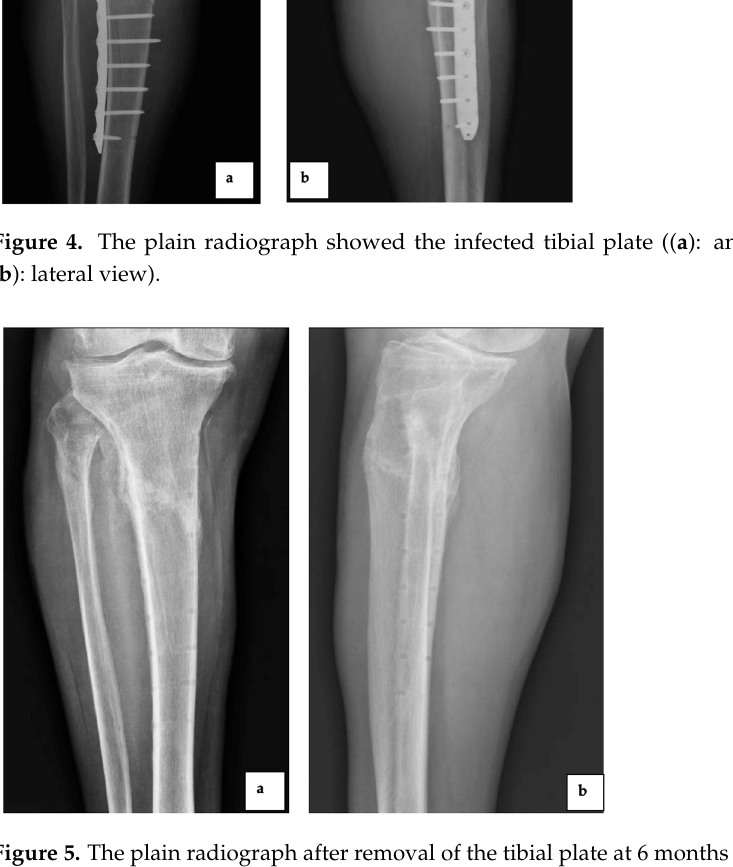
Figure 5. The plain radiograph after removal of the tibial plate at 6 months of follow-up (( a ): antero- posterior view and ( b ): lateral view).